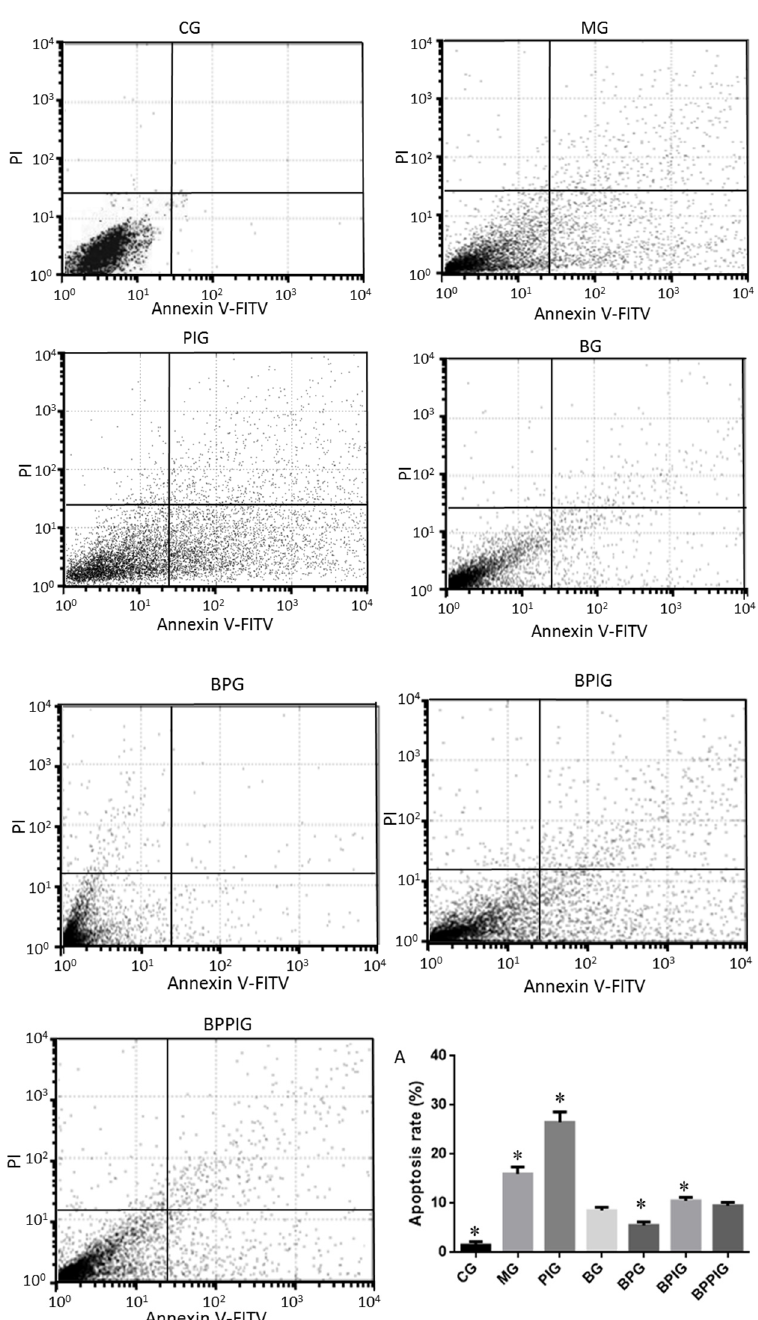
Figure 7. Flow cytometer analysis for the apoptosis of liver tissue: apoptotic rate of liver tissues in different groups ( A ). Eight liver samples were analyzed in each group. All data are presented as mean value ± S.D. * p < 0.05 via a blueberry juice group BG.